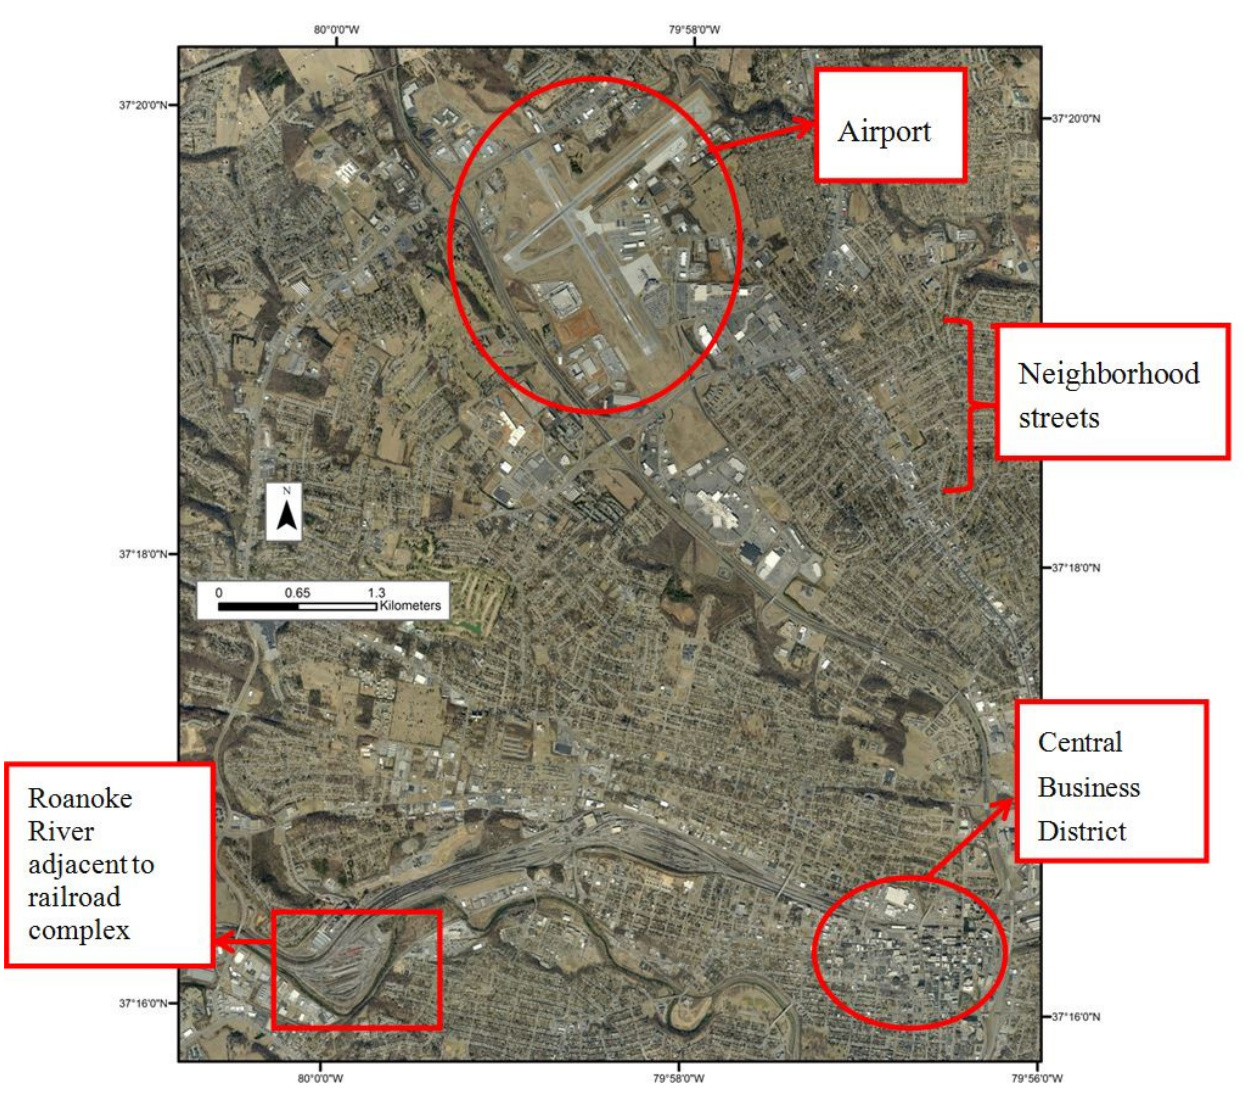
Figure 2. Specific locations for visual